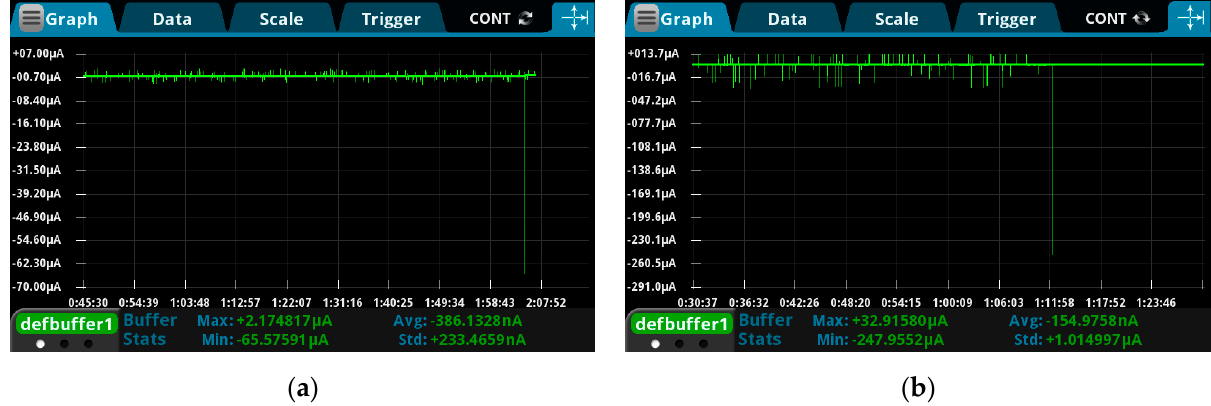
Figure 7. The maximum leakage current before breakdown under DC electric field. ( a ) The value under the uniform electric field; ( b ) the value under the non-uniform electric field.